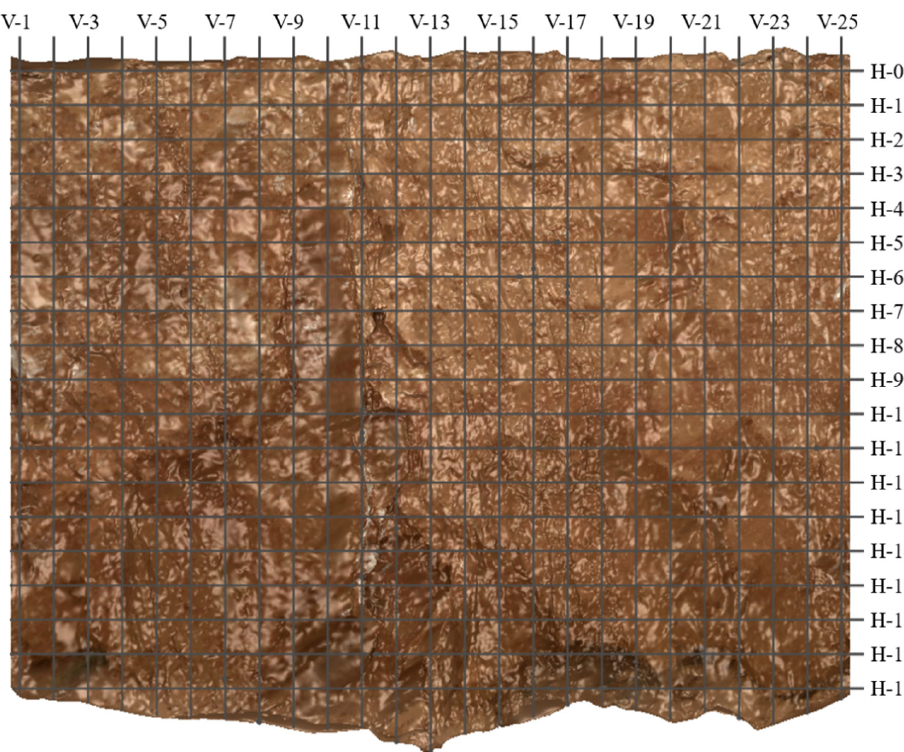
Figure 9. The cutting result.